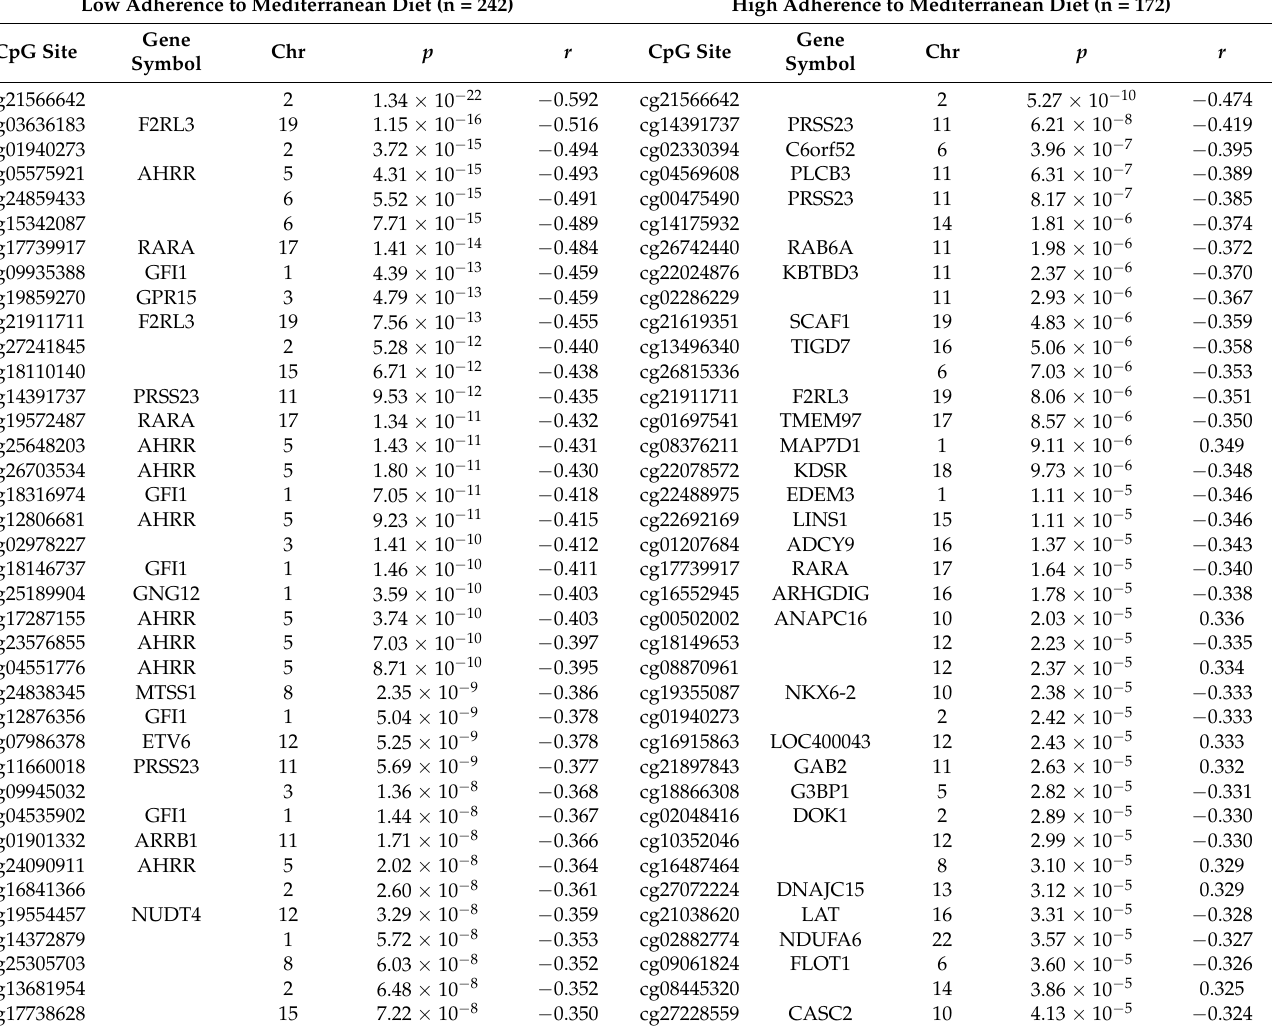
Table 7. Top differentially methylated CpGs for the epigenome-wide methylation analysis of tobacco smoking status (5 levels) 1 , depending on the level of adherence to the Mediterranean diet 2 , after multivariate adjustment 3